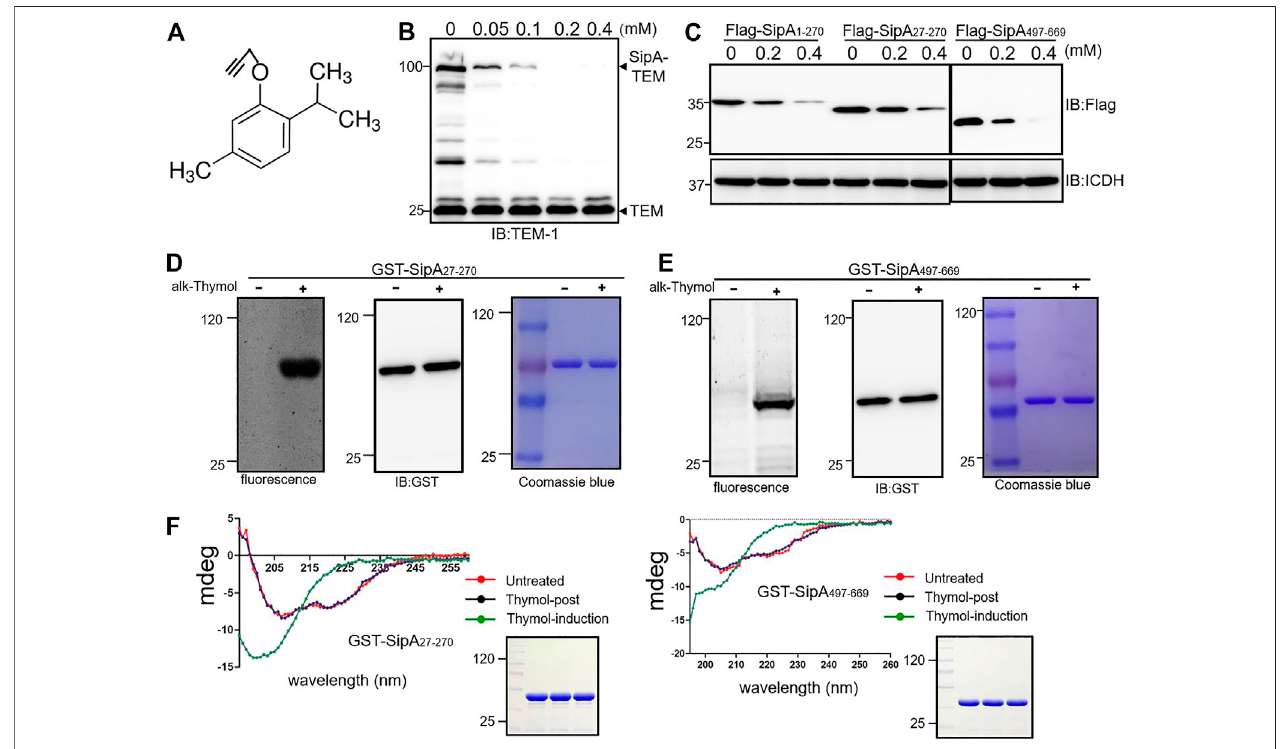
FIGURE 3 | Thymol induces conformational changes in SipA by interacting with two independent regions. (A) The chemical structure of alkyne-thymol. (B) The alkynemodi fi cation didnotaffecttheactivity ofthymol. Cellsofthe S .Typhimurium strainexpressing theSipA – lactamasetreatedwithdifferentconcentrationsofalkyne- thymol were probed for the fusion protein by immunoblotting. Note that the reduction only occurs in the level of SipA – lactamase fusion but not in the lactamase expressed from the plasmid backbone. (C) Thymol affects the stability of the two soluble regions of SipA. Thymol was added to cultures of cells expressing the indicatedSipAfragmentsfusedtoaFlagtag,andcelllysatesresolvedbySDS-PAGEwereprobedbyimmunoblottingwiththeFlag-speci fi cantibody.ICDHwasprobed as a loading control. (D,E) The binding between alkyne-thymol and two fragments of SipA. GST fusion of SipA 27-270 and SipA 497-669 expressed in cells exposed to alkyne-thymolorsolventcontrolreactedwithazido-conjugatedrhodaminewasprobedby fl uorescencescanning.Notethatineachcaseonlyproteinfromcellsgrownin the presence of alkyne-thymol retained the fl uorescence signals. (F) Thymol induces conformational changes in SipA fragments. GST-SipA 27-270 and GST-SipA 497-669 puri fi ed from E. coli or its lysates exposed to thymol or solvent were analyzed by circular dichroism (CD) spectroscopy. Note that proteins from cells treated with thymol (green curve: thymol-induction) assume structures that differ greatly from those not exposed to thymol (red curve: untreated) or exposed to the compound (blue curve: thymol-post)after proteintranslation,untreated, thymol-post,andthymol-inductiontwisted antiparallel β -structures.Theexperimentswererepeatedatleastthreetimes each with independent biological